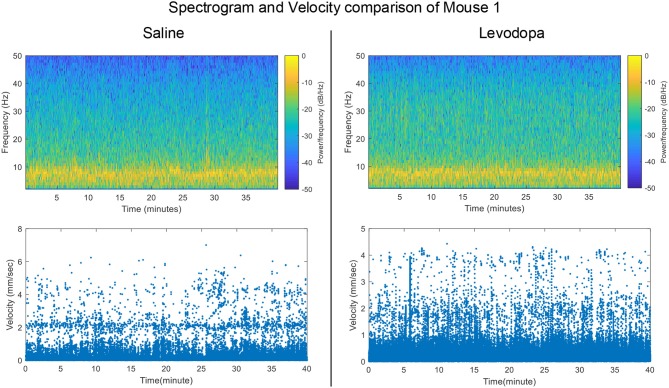
Spectrogram of Striatal LFP signals and velocity comparisons in saline-injected session (left) and levodopa-injected session (right) of Mouse 1.